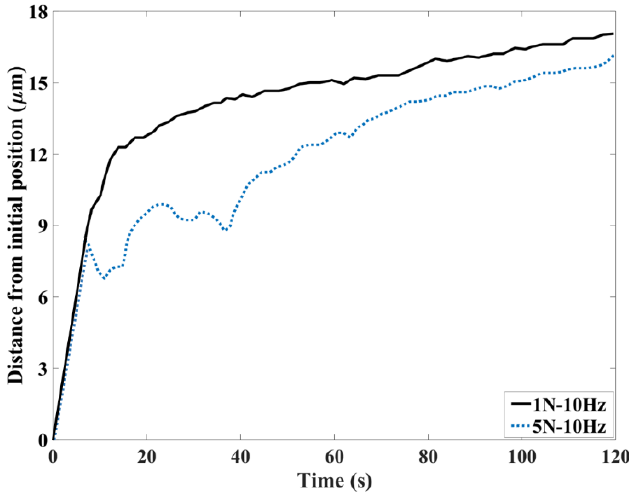
Figure 9. E ff ect of load on wear. Figure 9. Effect of load on wear. Figure 9. Effect of load on wear.